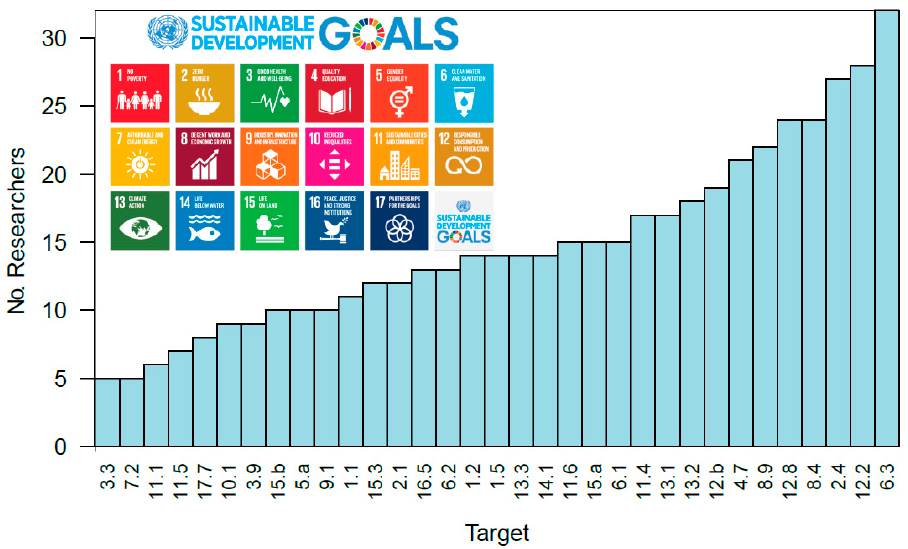
Figure 3. Number of times (y-axis) each Sustainable Development Goal (SDG) target (x-axis) has appeared in the surveys as one of the top 10-SDG target priorities with focus in the 45 wetlandscapes studied worldwide.